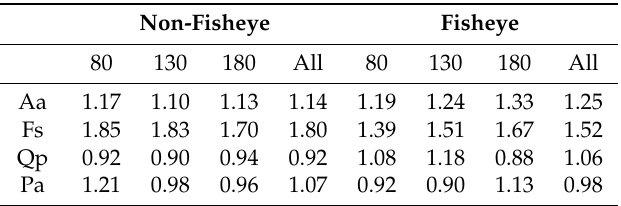
Table 4. RMSE% of diameter estimation (Aa: Abies alba ; Fs: Fagus sylvatica ; Qp: Quercus petraea ; Pa: Picea abies